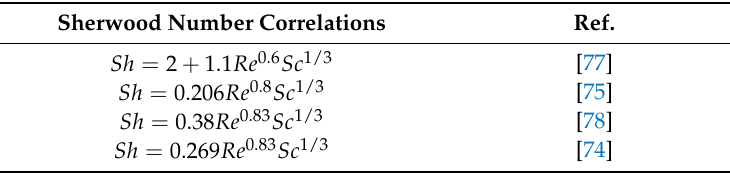
Table 5. Mass transfer coefficient